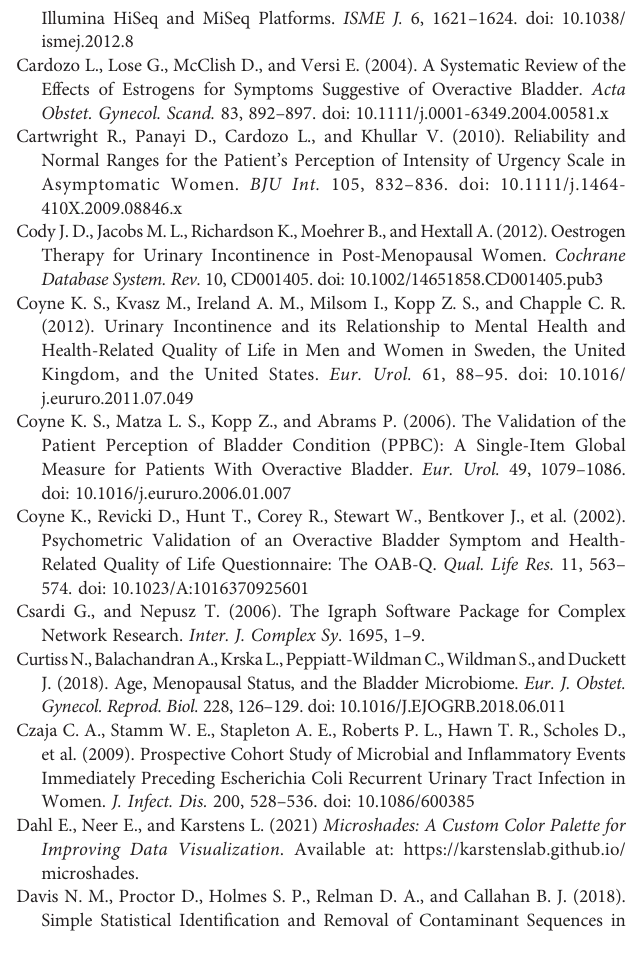
Supplementary Figure 1 | Principal Coordinate Analysis (PCoA) for the vaginal microbiome. (A) PCoA using Bray-Curtis distance; (B) PCoA using unweighted UniFrac distance; (C) PCoA using weighted UniFrac distance. Supplementary Figure 2 | Principal Coordinate Analysis (PCoA) for the urinary microbiome. (A) PCoA using Bray-Curtis distance; (B) PCoA using unweighted UniFrac distance; (C) PCoA using weighted UniFrac